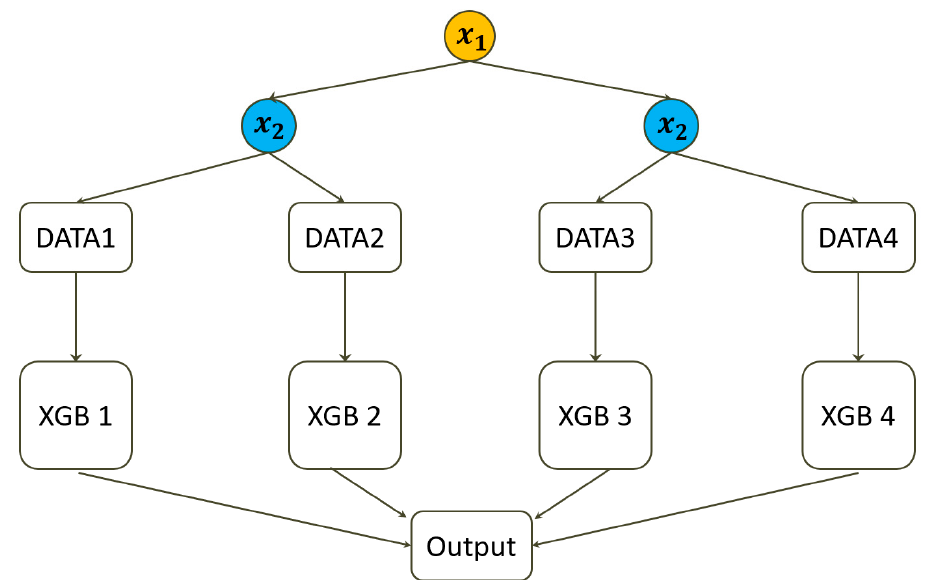
Figure 1. The data structure of the XGB-FI.